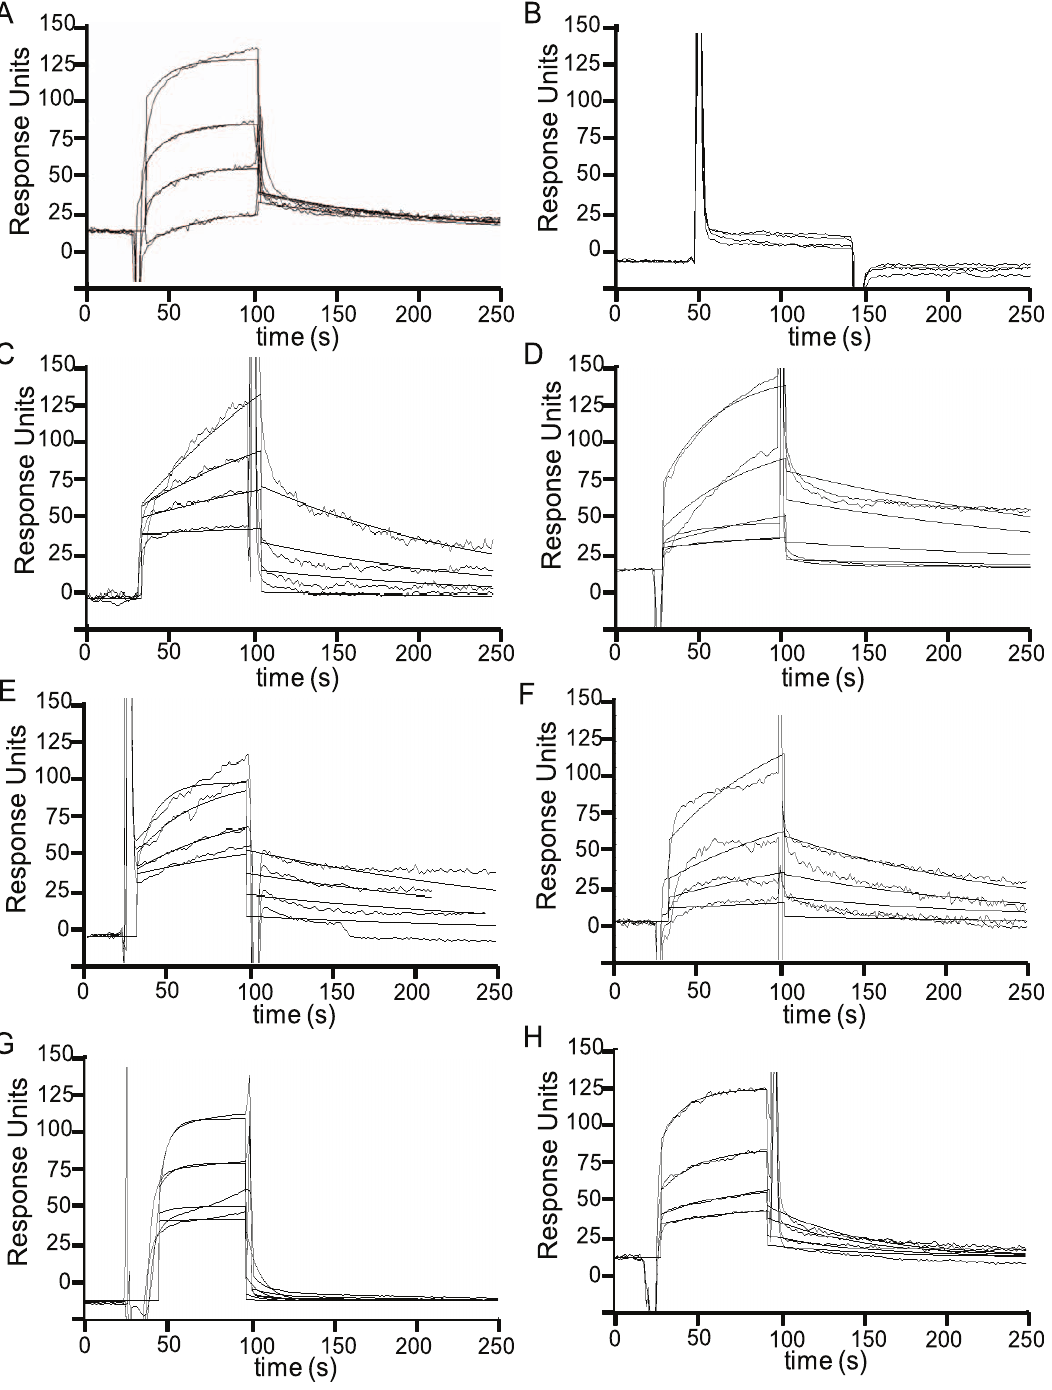
Figure 2. SPR analysis results. Sensorgrams obtained by injecting different concentrations (from 0.020 to 1 m M) of 1 (A), 2 (B), 3 (C), 4 (D), 5 (E), 6 (F) 7 (G) and radiciol (H) on immobilized Hsp90.